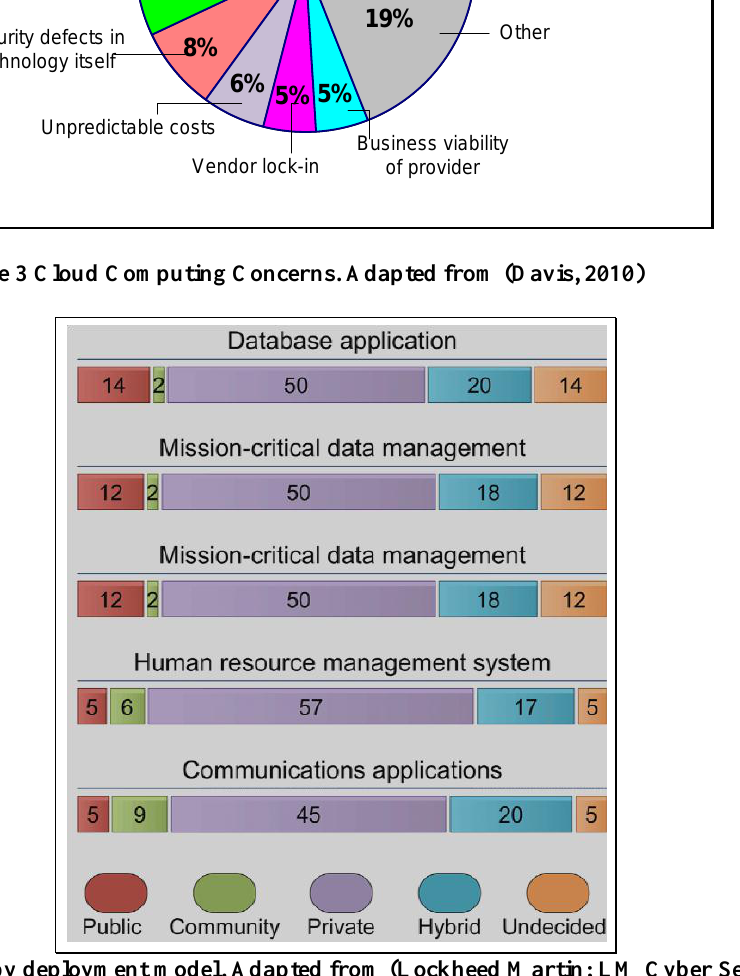
Figure 4 Adoption of services by deployment model. Adapted from (Lockheed Martin; LM Cyber Security Alliance; Market Connections, Inc.,